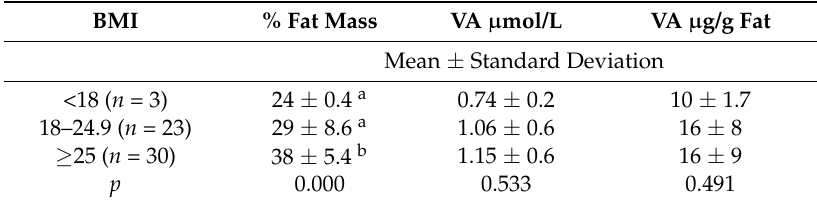
a,b Different letter in column means statistical